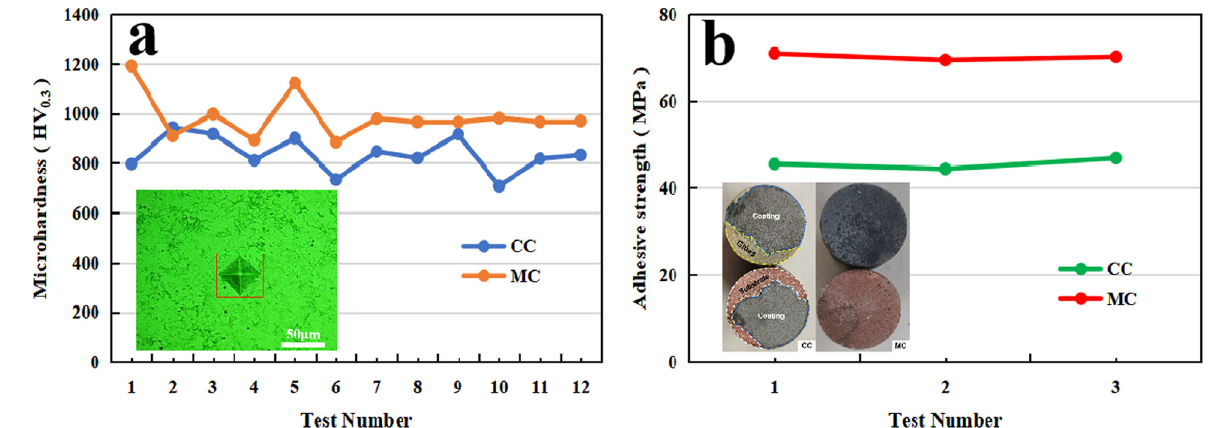
Figure 9: Microhardness and adhesive strength of the Cr 3 C 2 – NiCr coatings. ( a ) Microhardness, ( b ) adhesive